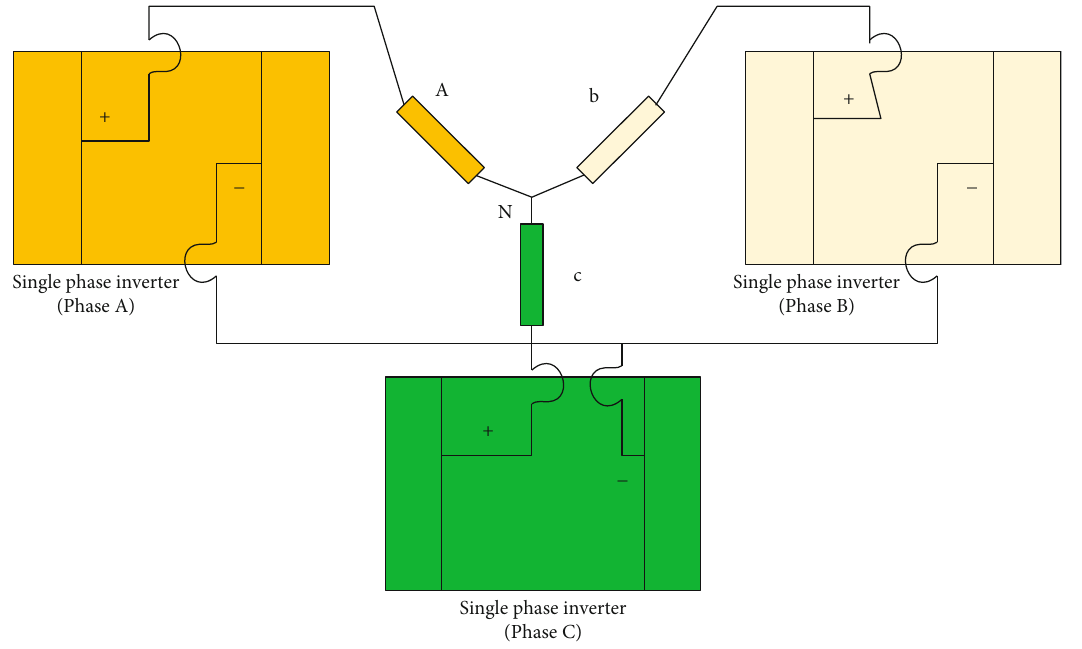
Figure 27: Three-phase inverter connection.